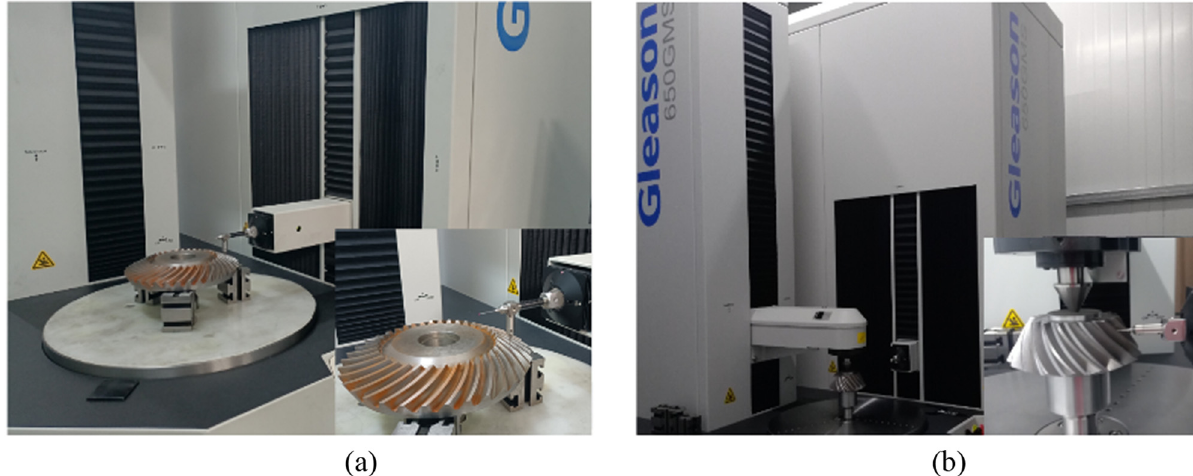
Fig. 14. Scene of measurement. (a) Gear. (b) Pinion.